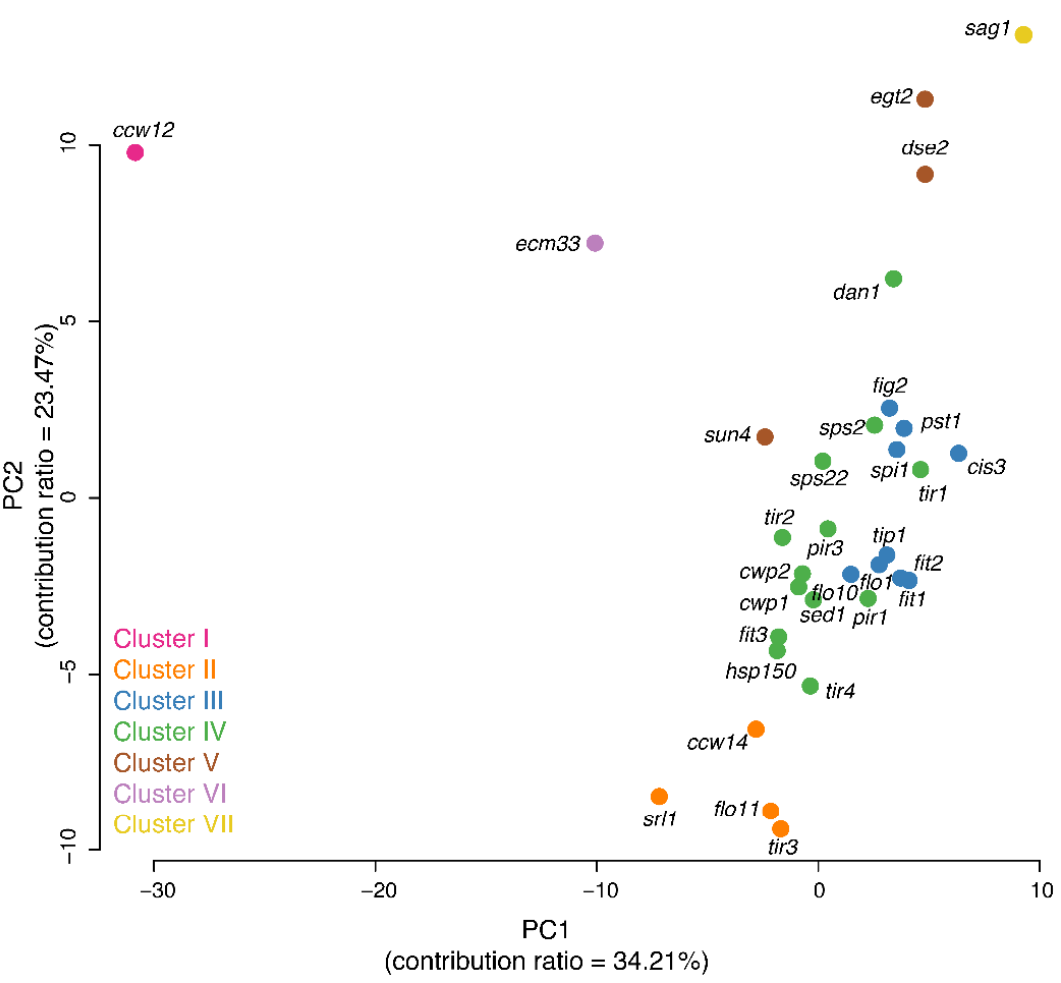
Figure 1. Two-dimensional principal component (PC) analysis score plot (biplot) illustrating clustering of the 32 mannoproteins. Each circle represents a single mannoprotein deletion mutant. The mixture likelihood values at individual points, based on the first five PC scores (CCR = 81.34%; Figure S1A) and a seven-component EEI model (Figure S1B), revealed data trends, including seven clusters. Mutants are color-coded.